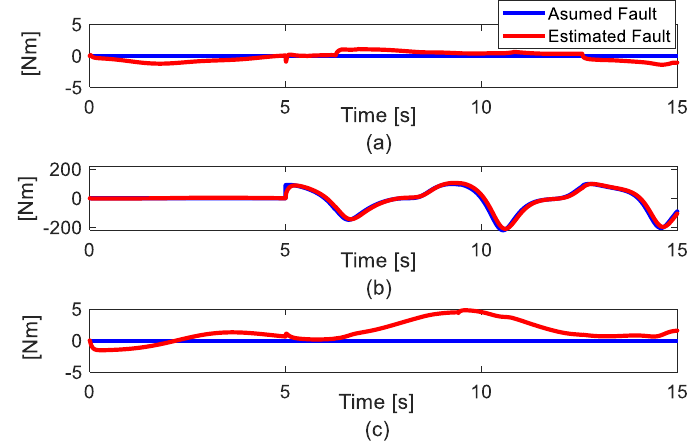
12 of 18 Figure 3. Tracking error results. Blue line is [30]+ESO controller. Red line is the proposed control- ler. ( a ) Joint 1; ( b ) Joint 2; ( c ) Joint (3). 5.2. Simulation 2 In this subsection, the total two kinds of actuator fault with a similar magnitude of fault to Simulation 1 are considered. The assumed fault function is shown as 11 2222 33 ( 1